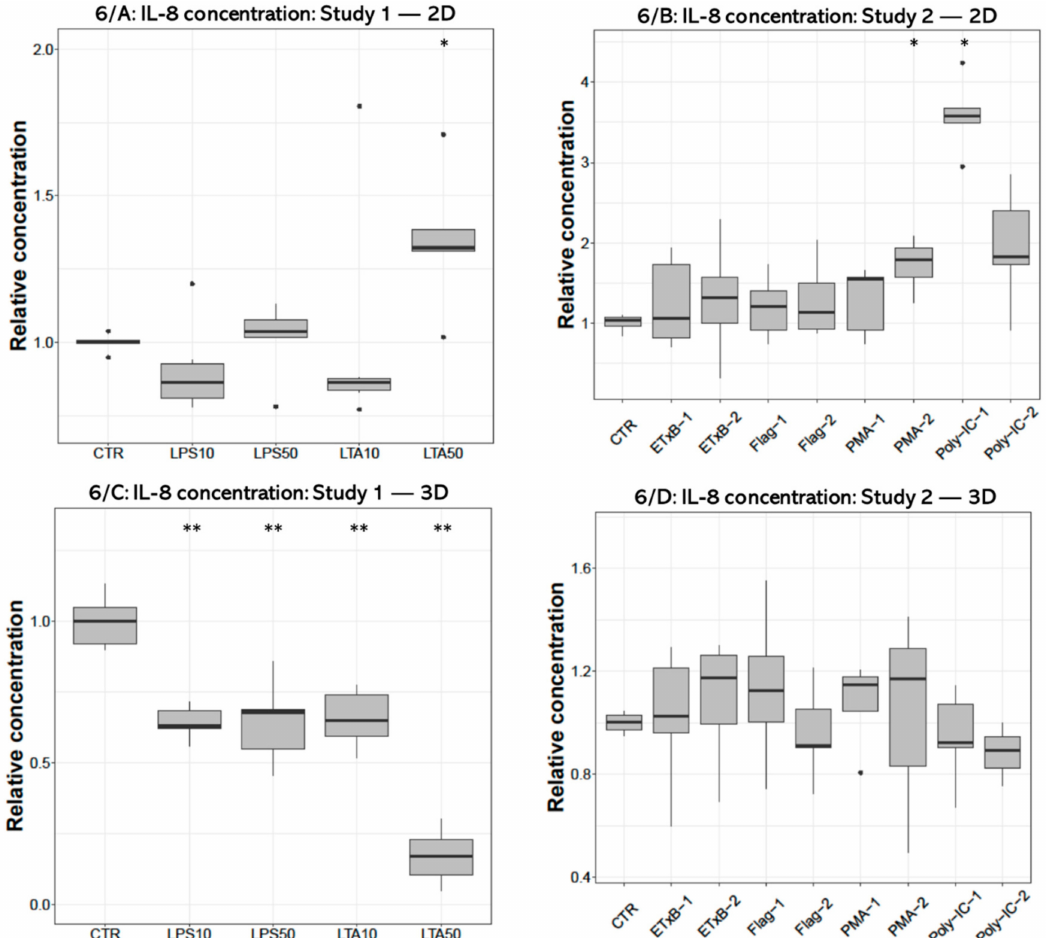
Figure 6. Boxplots showing the interleukin-8 (IL-8) concentration in cell culture media of hepatocyte—non-parenchymal cells in 2D (Study 1: ( A ) and Study 2: ( B )) and 3D (Study 1: ( C ) and Study 2: ( D )) co-cultures detected by a chicken specific ELISA assay (n study 1 = 6/group, n study 2 = 5/group). Relative concentrations were calculated by considering the mean value of control cultures as 1. The “CTR” refers to control cells that received none of the treatments. The treatments were: LPS10 and LPS50 = 10 and 50 µ g/mL lipopolysaccharide (LPS) from Escherichia coli , LTA10 and LTA50 = 10 and 50 µ g/mL lipoteichoic acid (LTA) from Staphylococcus aureus , ETxB-1 and -2 = 20 and 50 µ g/mL subunit B of heat-labile enterotoxin of Escherichia coli , Flag-1 and -2 = 100 and 250 ng/mL flagellin from Salmonella Typhimurium, PMA-1 and -2 = 100 and 1000 ng/mL phorbol myristate acetate (PMA), poly-IC-1 and -2= 50 and 100 µ g/mL polyinosinic polycytidylic acid (poly I:C). Asterisks over the boxes refer to significant differences compared to “CTR” cells within the same cell culture model and the same study. * p < 0.05, ** p <